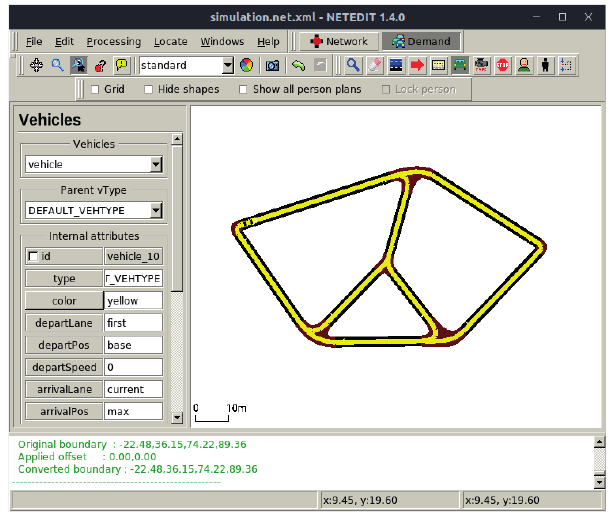
Fig. 8. The design of our scenario using